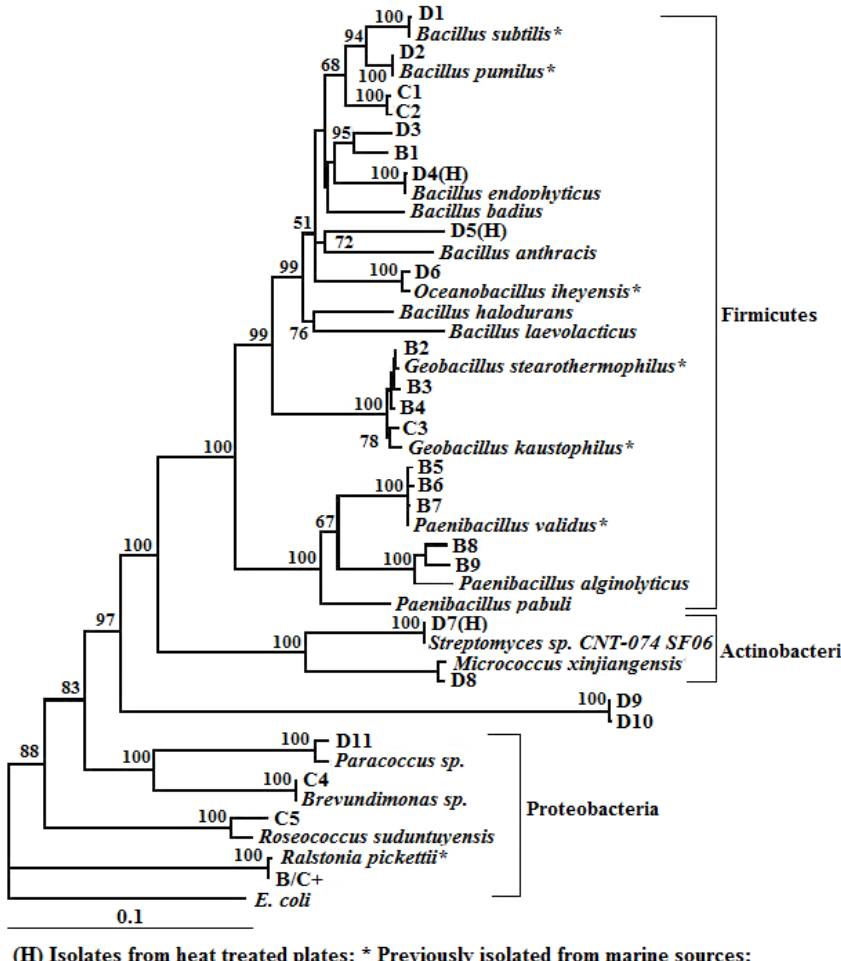
Fig. 3. A neighbor joining tree shows the phylogenetic relationships among our environmental clone library sequences, plate colony se- quences, and their top sequence matches obtained through NCBI BLAST. The distance tree is based on a sequence alignment spanning over a 1.339 nucleotide region of the 16S rRNA gene and is rooted with Escherichia coli . The distances were calculated using the HKY85 nucleotide model. The bootstrap analysis was done using 100